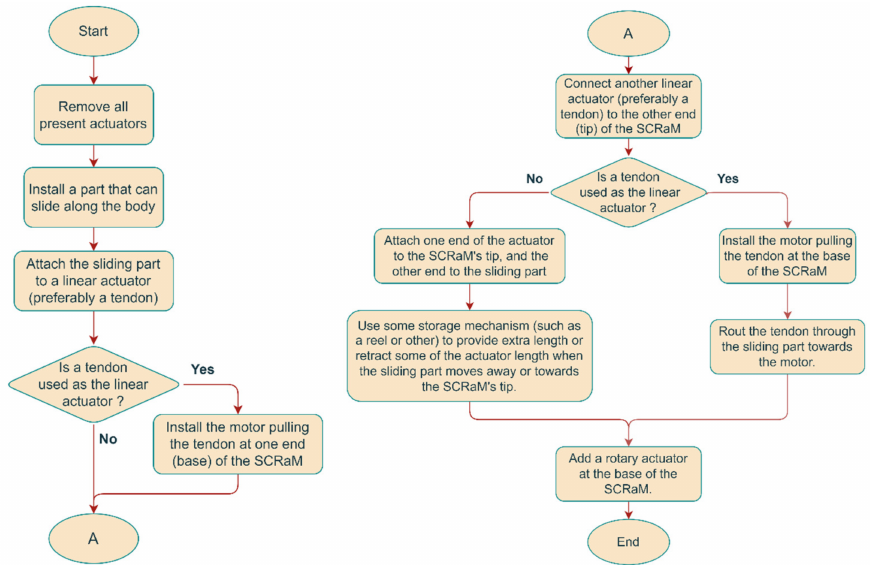
Figure 4. Steps to reduce the number of actuators in multi-segment